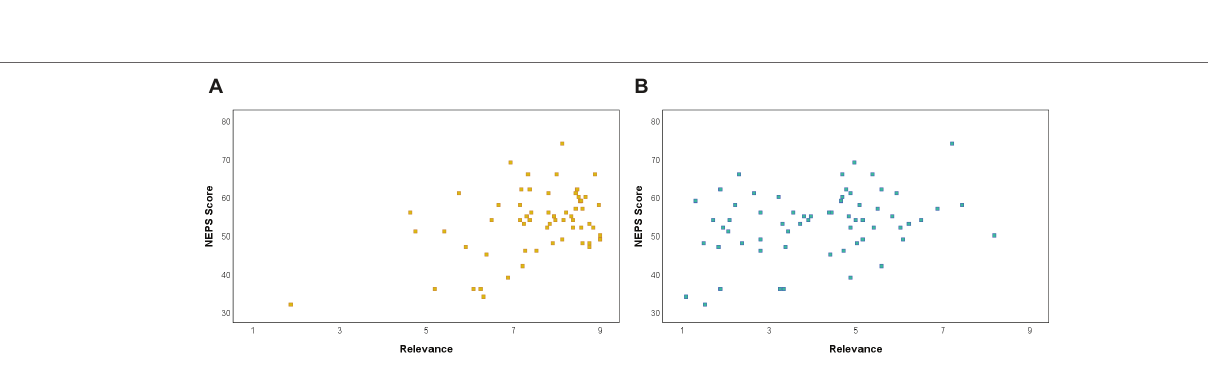
FIGURE 5 | (A) There was a strong, positive relationship between the average relevance ratings of the images determined to be most relevant to climate change and participants’ score on the NEP Scale. (B) There was a moderate, positive relationship between the average relevance ratings of the images determined to be least relevant to climate change and participants’ score on the NEP